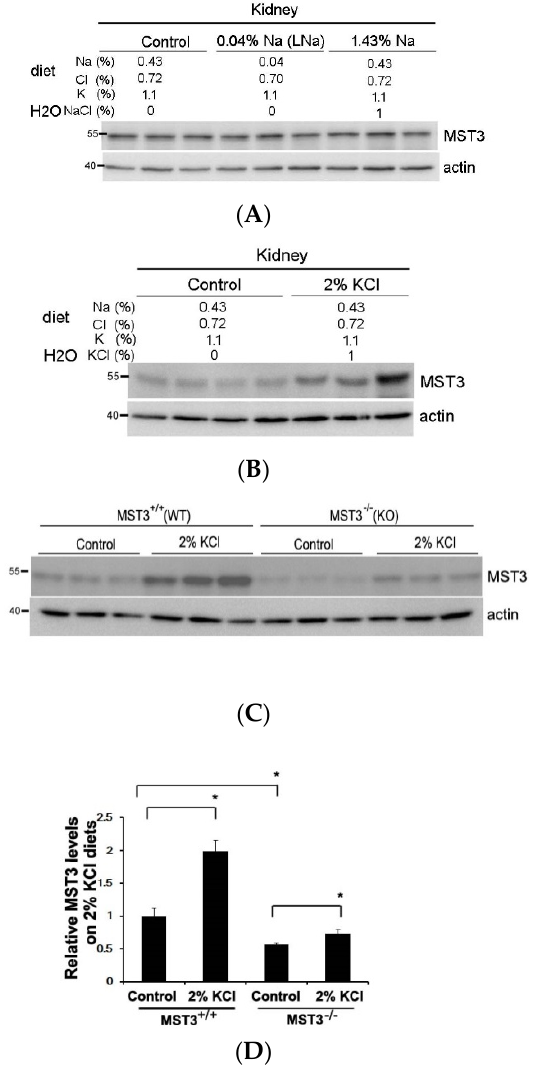
Figure 2. A 2% KCl diet stimulates MST3 expression. MST3 protein expression was detected in WT mice fed the ( A ) control (n = 3 or 4 animals), low Na (LNa), 1.43% Na or ( B ) 2% KCl diets for 16 days (n = 3 animals/group). The sodium, potassium, chloride and water contents in the diet are indicated. ( C ) MST3 protein expression was detected in WT and MST3 − / − mice fed the control and 2% KCl diets (n = 3 animals/group). ( D ) The bar graph shows quantification of MST3 expression in ( C ). * p < 0.05 vs. the control